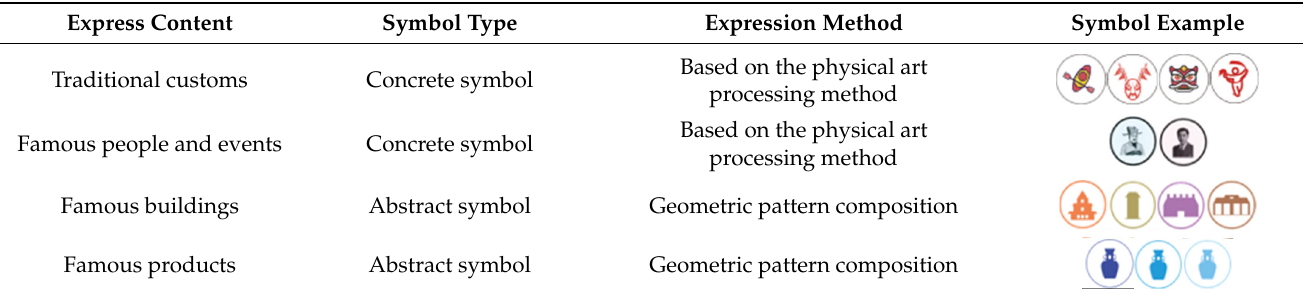
Table 2. The symbol design of the thematic map.